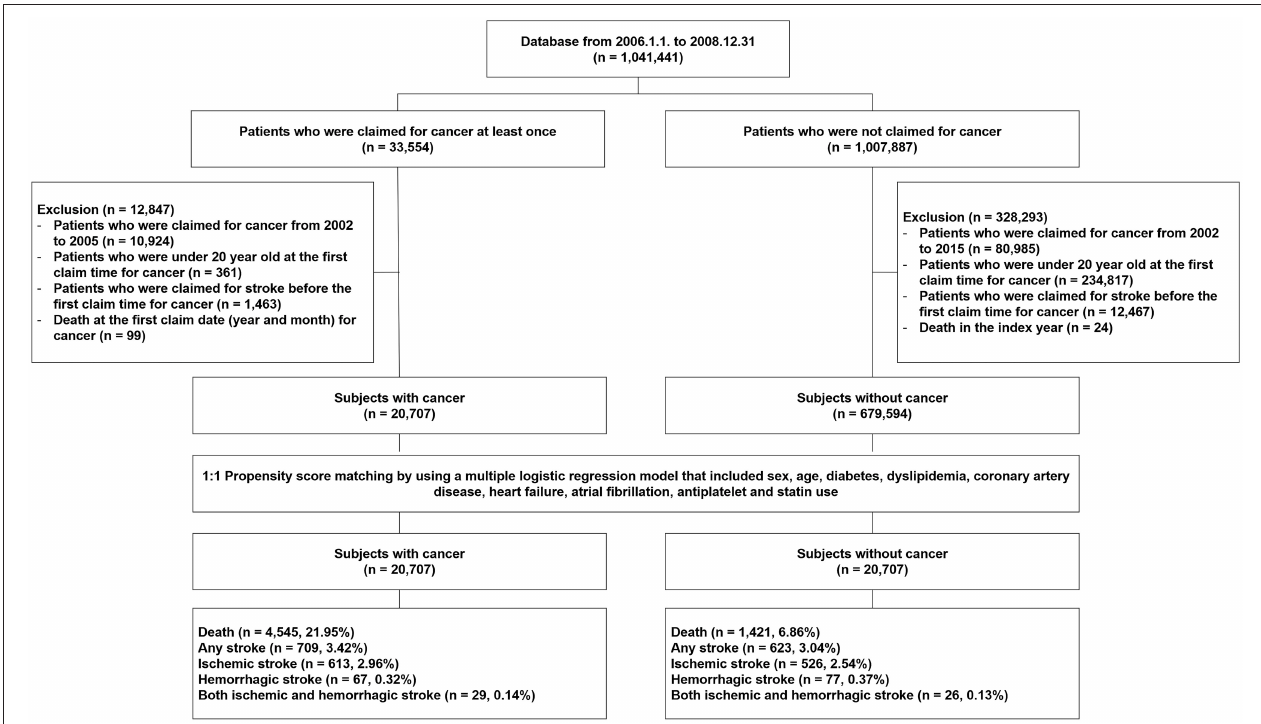
FIGURE 1 | Selection of study subjects from the National Health Insurance Service National Sample Cohort database of South